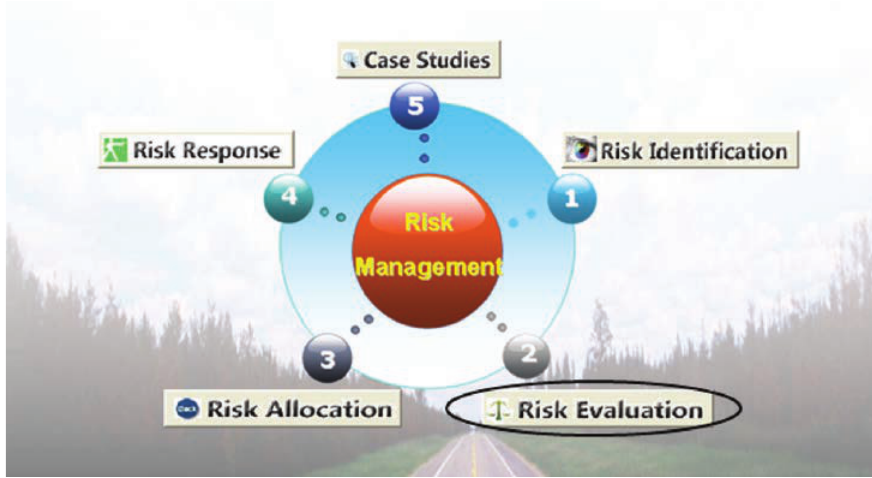
figure 3. Interface of risk management